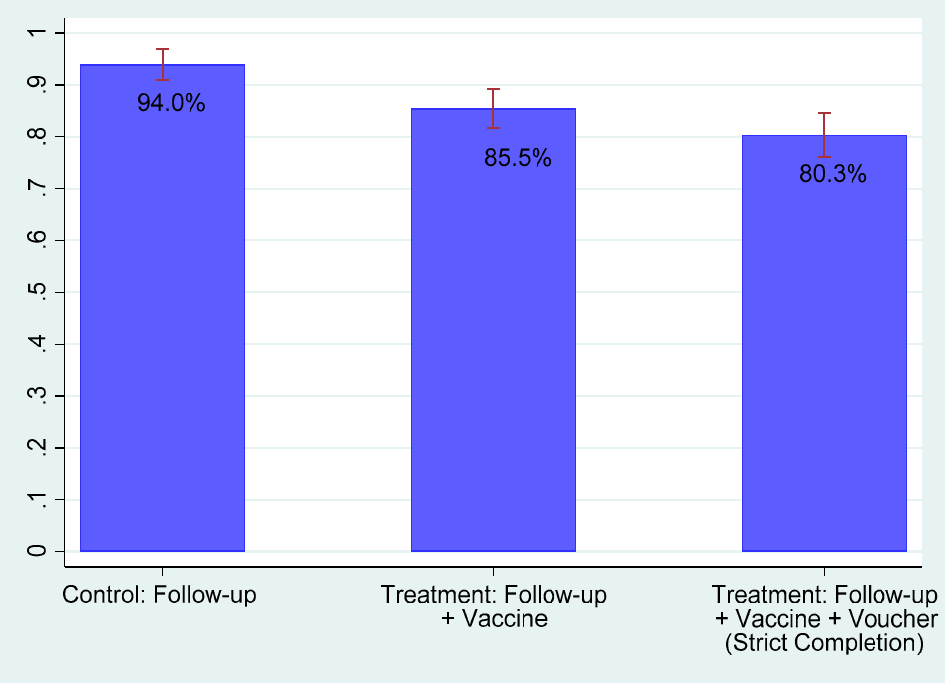
Figure 5. Completion rate by treatment status. Notes: “Completion” in the control group means the completion of the follow-up survey (control task). “Completion” in the treatment group is the completion of the follow-up survey and vaccination (treatment task). “Strict Completion” in the treatment group is the completion of the follow-up survey, vaccination, and the submission of the voucher (strict treatment task). The confidence interval is at a 95%